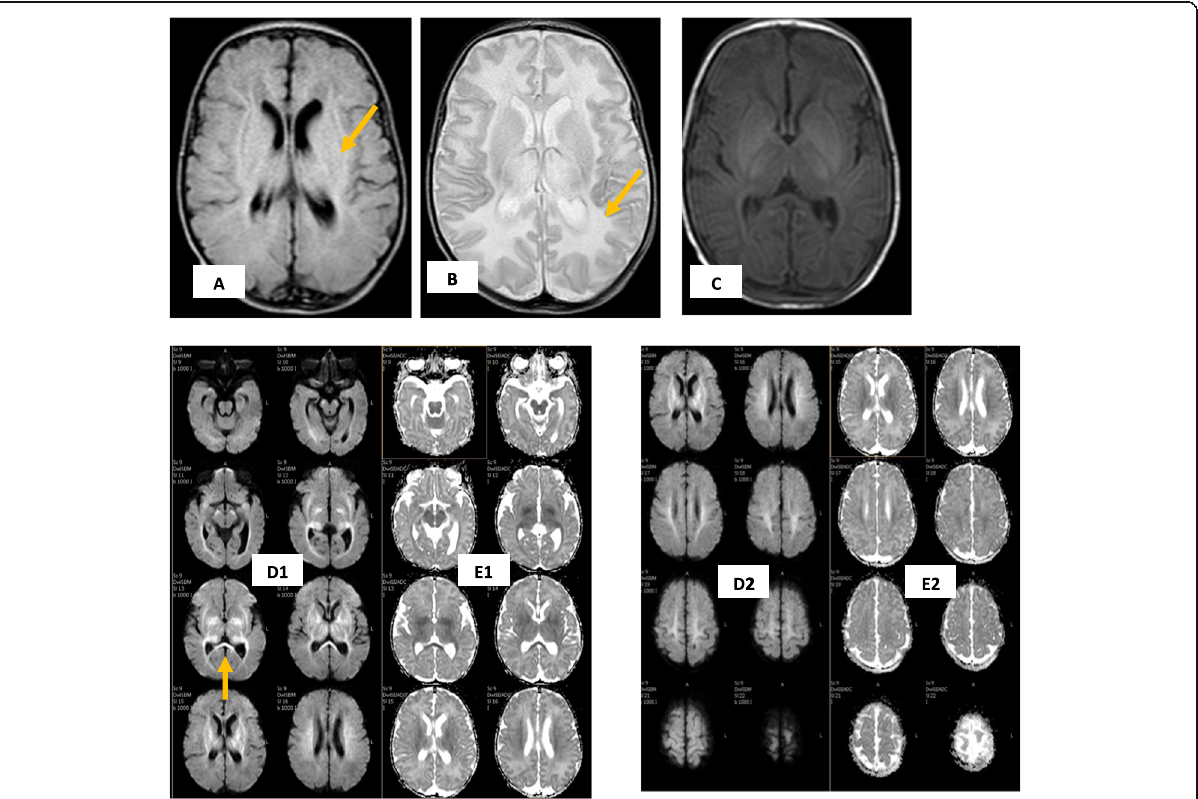
Fig. 2 3-months-old girl with sever HII . Different sequences MRI showed high FLAIR signal (yellow arrow in A ) at both BG, thalami as well as the white matter (yellow arrow in B ) extending to the corpus callosum (yellow arrow in D1 ), hippocampus and corticospinal tracts (basal ganglia- thalamic pattern). DWI showed restricted diffusion in acute